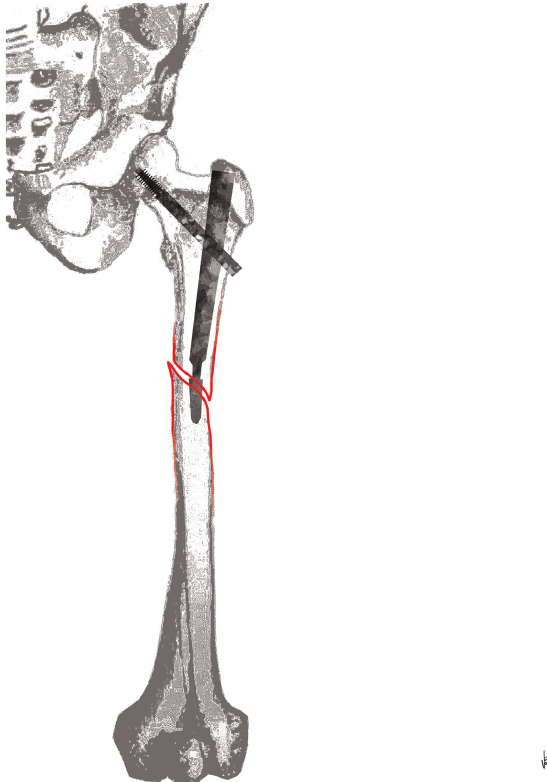
Figure 4: A drawing representing a BO2